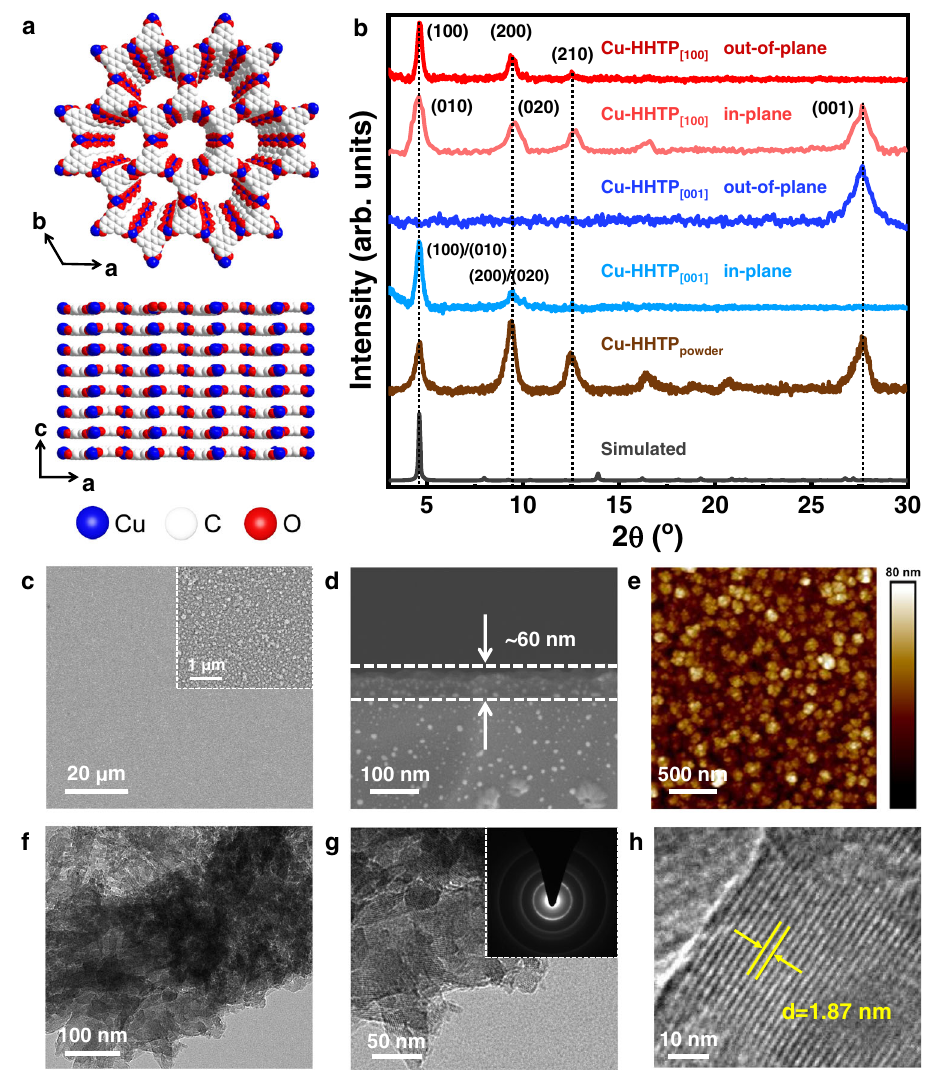
Fig. 2 | Structural analysis and morphological characterization of Cu-HHTP fi lms. a Structural models of Cu-HHTP along c-axis (top) and b-axis (down), H atoms are omitted for clarity. b The out-of- and in-plane XRD patterns of Cu- HHTP [001] and Cu-HHTP [100] fi lms, and XRD pattern of Cu-HHTP powder in